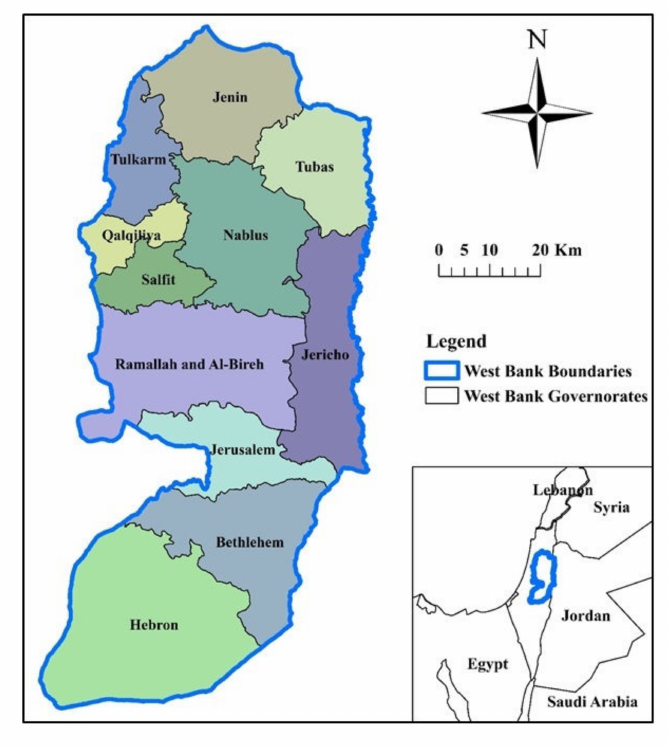
Figure 1. Location map of the West Bank, Palestine.